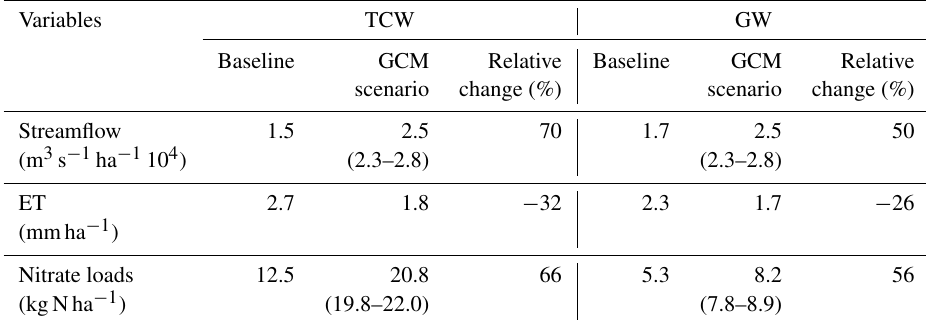
Table 6. The 14-year average of hydrologic variables under the baseline and GCM scenarios.